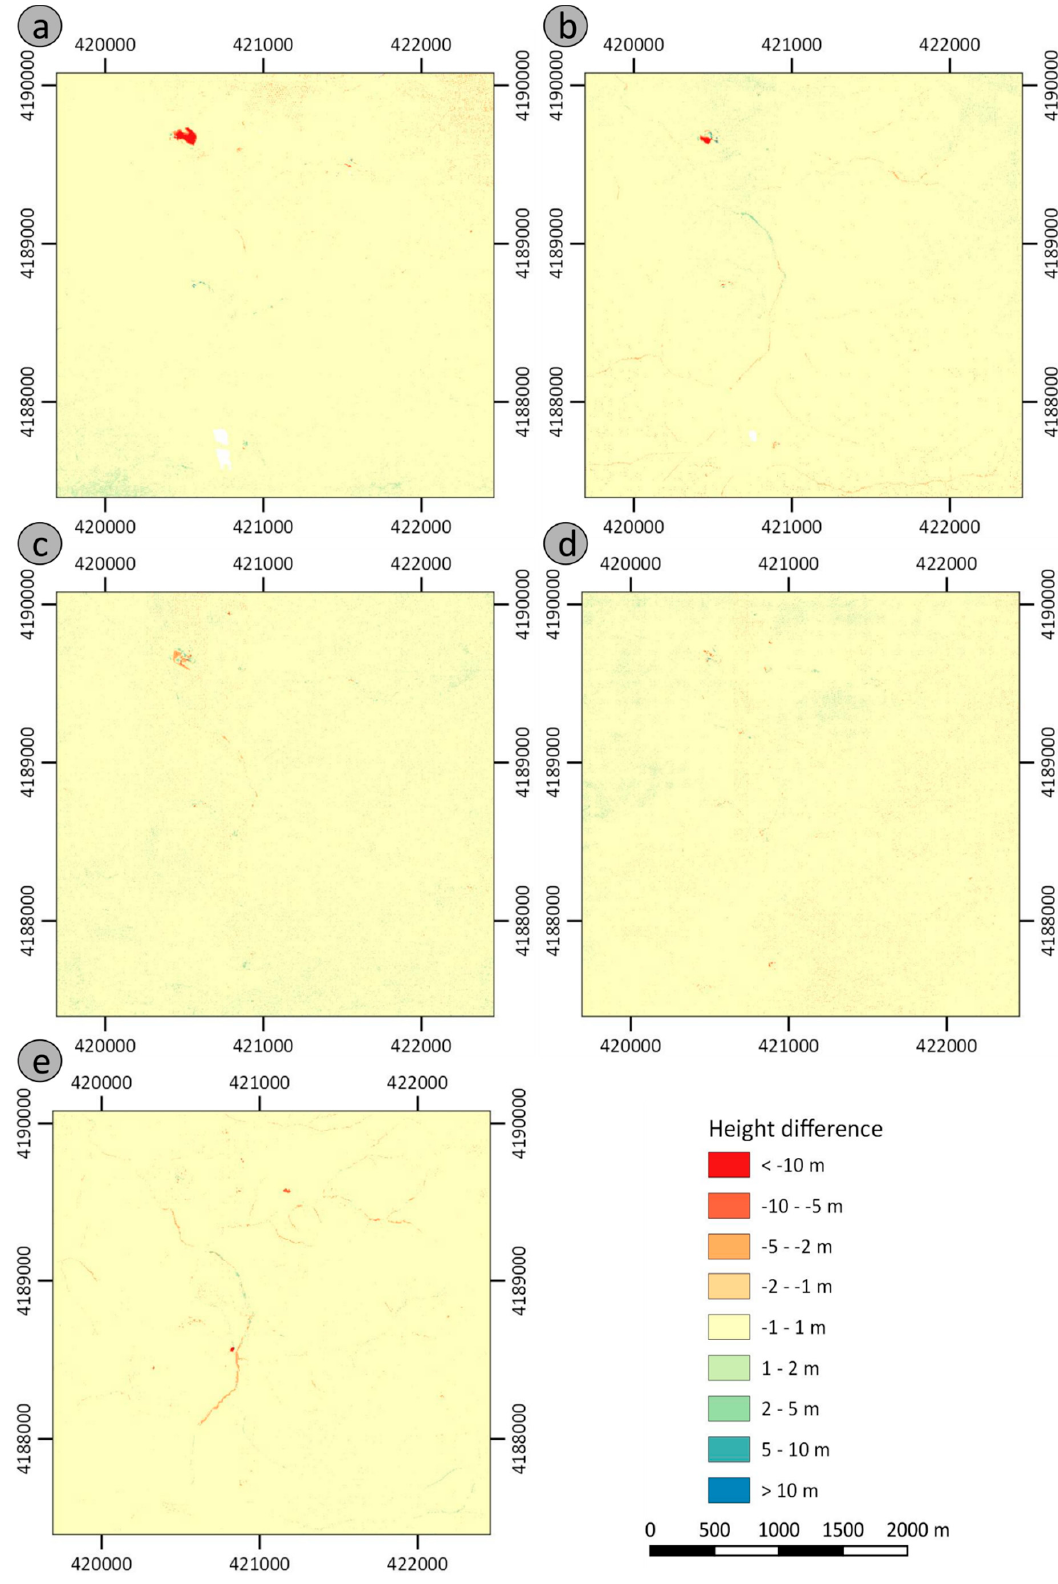
Figure 6. Figure 6. DSMs of differences (DoDs) of the whole area: ( a ) period 1980–1996; ( b ) period 1996–2001; ( c ) period 2001–2005; ( d ) period 2005–2009; ( e ) period 2009–2011. Coordinates are in ETRS89/UTM30.